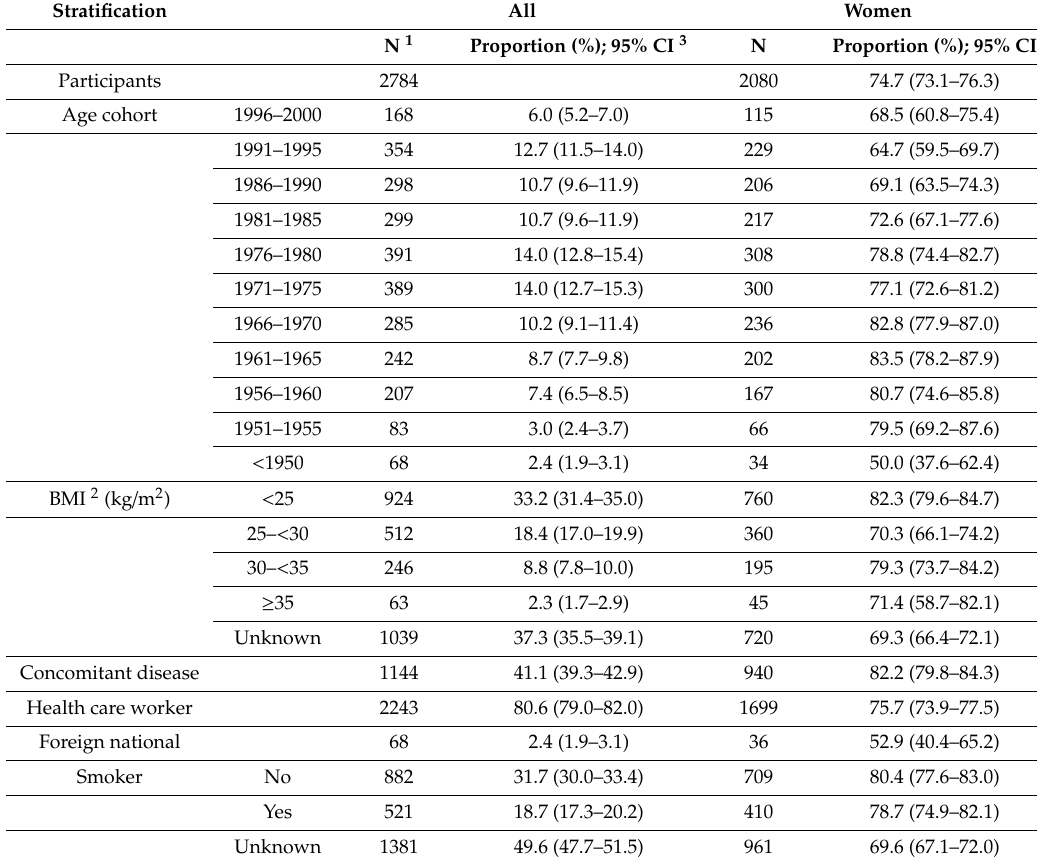
Table 1. Number and proportion of participants (including the 95% confidence intervals) stratified by assessed demographic, behavioural and health